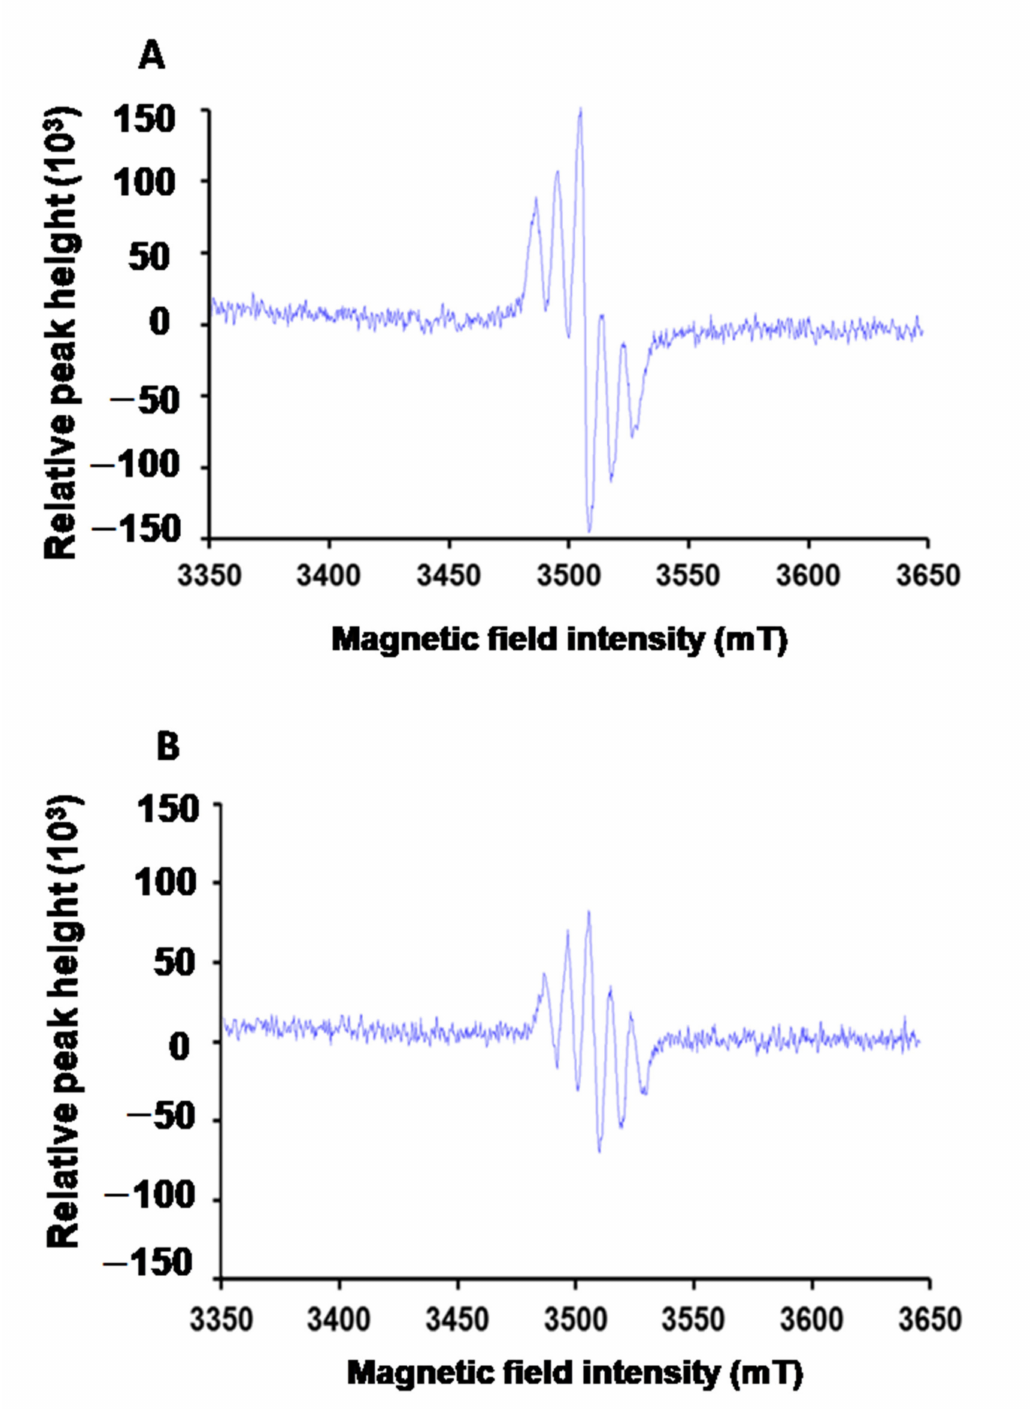
Figure 6. Anti-free radical efficiency of DPPH ( A ) and JNDs ( B